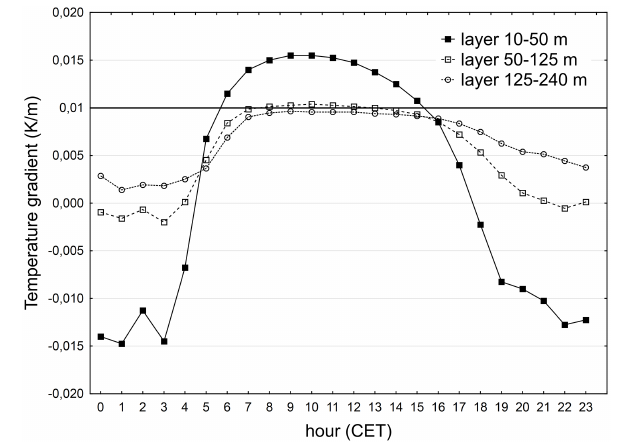
Figure 2. Daily course of summer medians of bulk vertical temper- ature gradient across three layers.